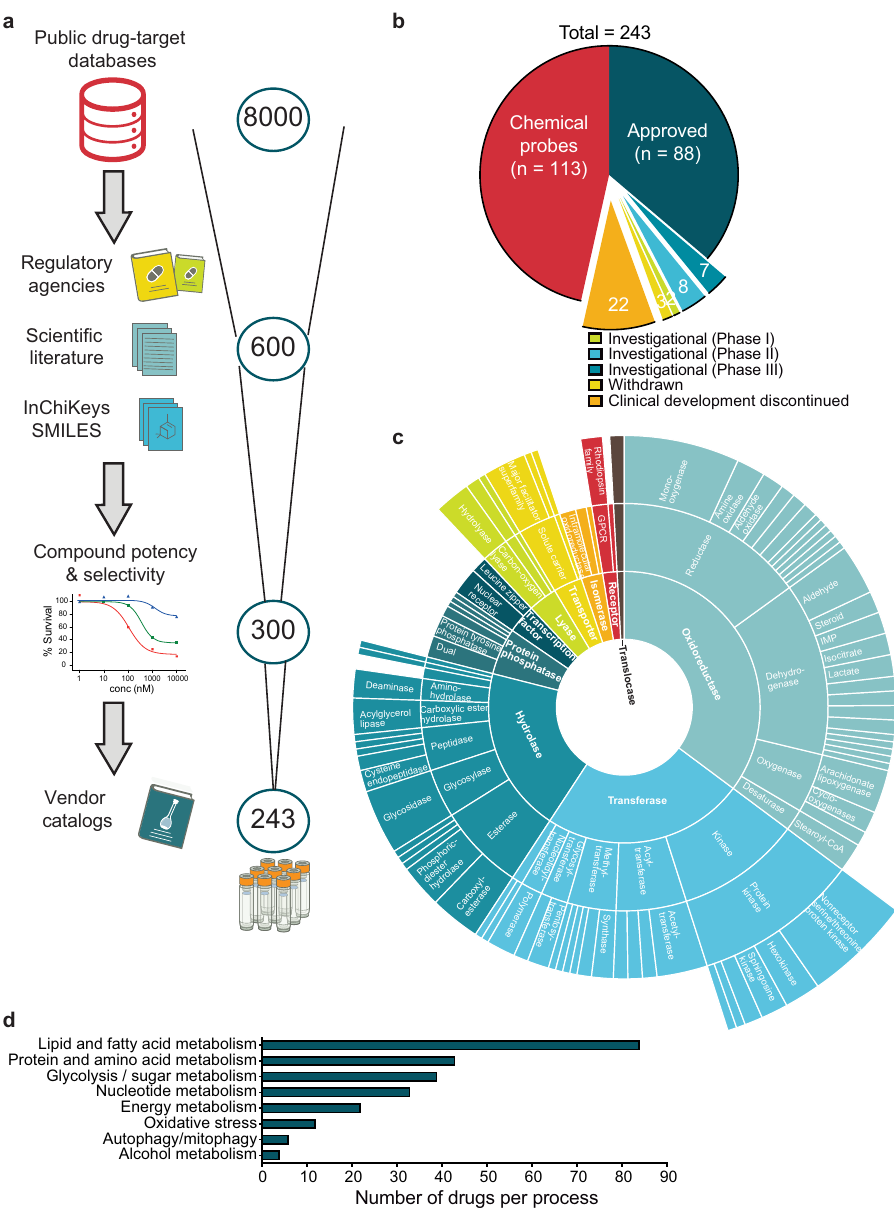
Fig. 1 Work fl ow and features of the CeMM library of metabolic drugs (CLIMET). a The process of library creation is shown, with compounds selected based on approval status, scienti fi c literature, structural information, potency and selectivity toward the intended target, and commercial availability. Selected graphics were modi fi ed from Servier Medical Art, licensed under a Creative Common Attribution 3.0 Generic License, http://smart.servier.com/. b Pie chart depicting the approval status of the compounds included in the library. c Sunburst visualization of protein function hierarchy categorization with growing speci fi city of function relating to distance from the fi gure center and size of each segment comparative to the fraction of the library targeting each protein class. The library is enriched with compounds targeting oxidoreductases, transferases and hydrolases. d Number of compounds targeting different metabolic pathways and